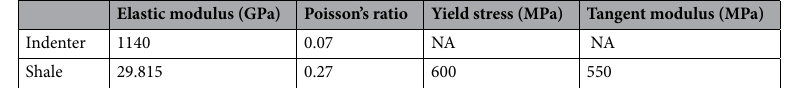
Table 2. The simulation input parameters for the nanoindentation experiment of